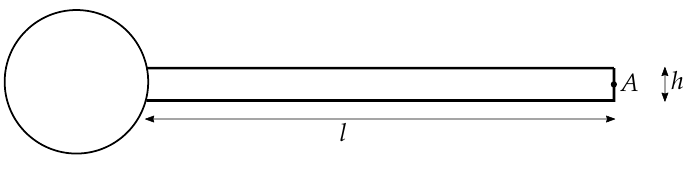
Figure 1. Setup of the benchmark problem: elastic beam attached to a rigid